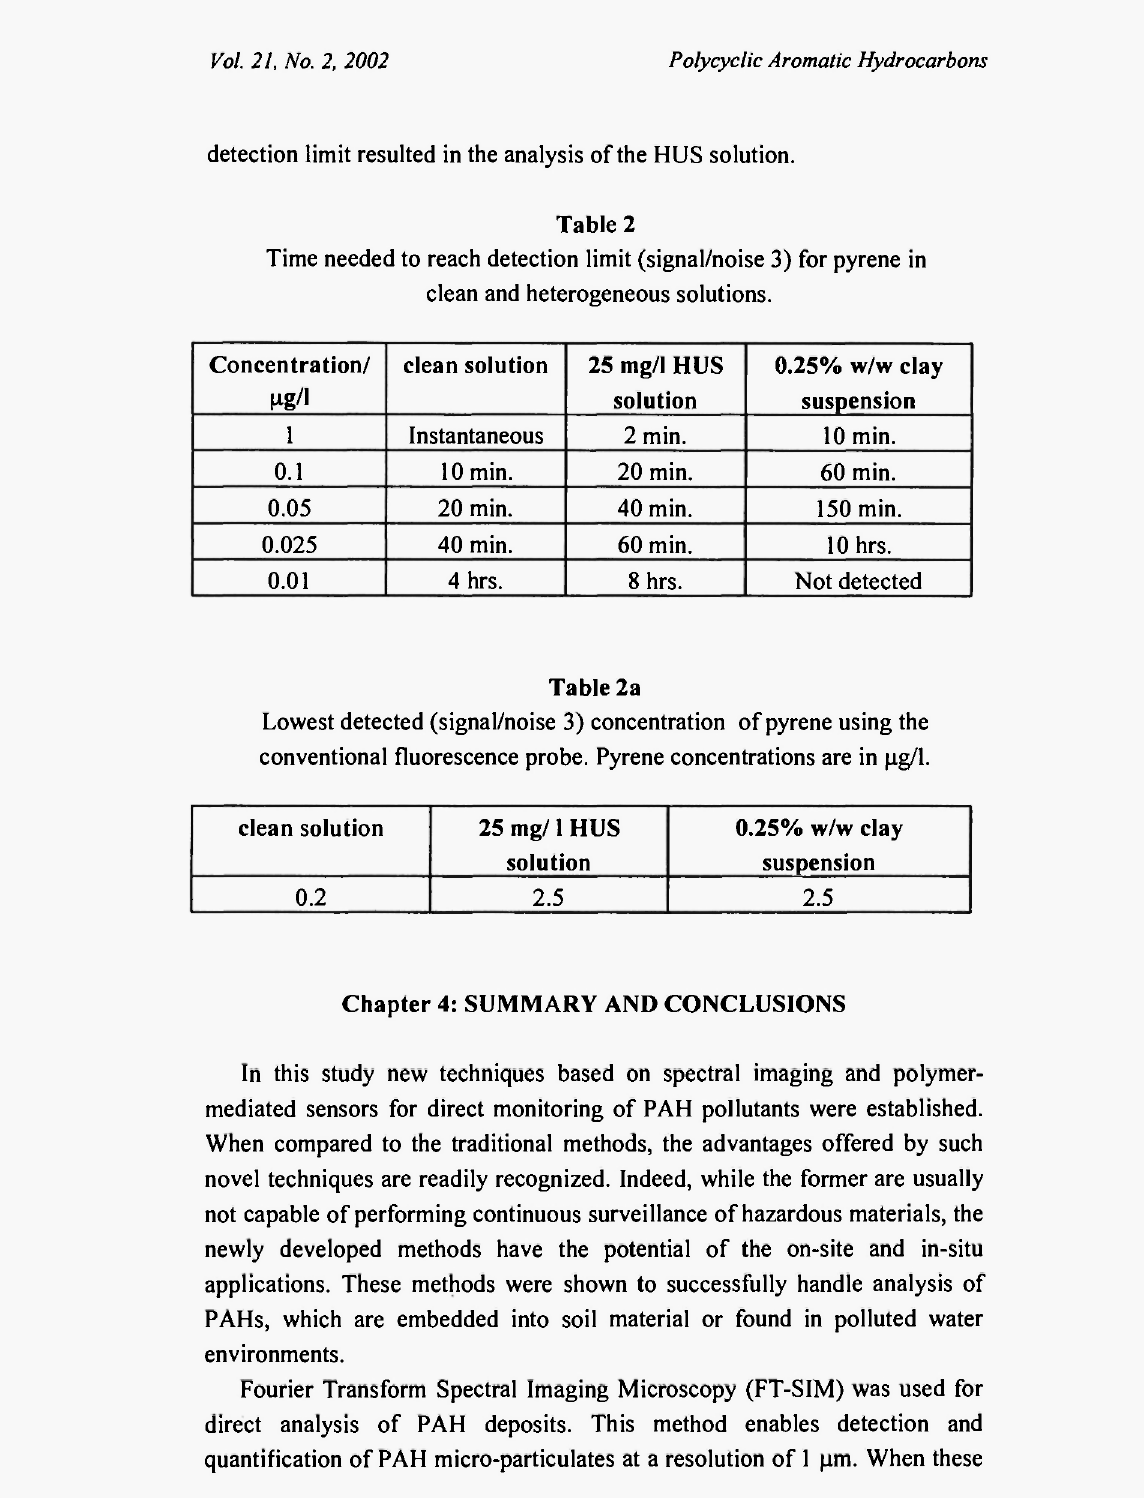
Lowest detected (signal/noise 3) concentration of pyrene using the conventional fluorescence probe. Pyrene concentrations are in